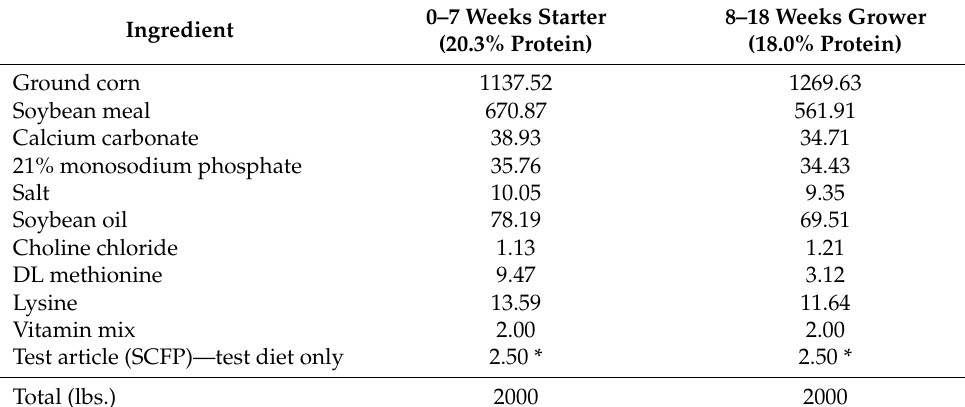
Table 2. Basal diet formulations (lbs./ton) for starter and grower rations without (CON) and with test-article inclusion at milling